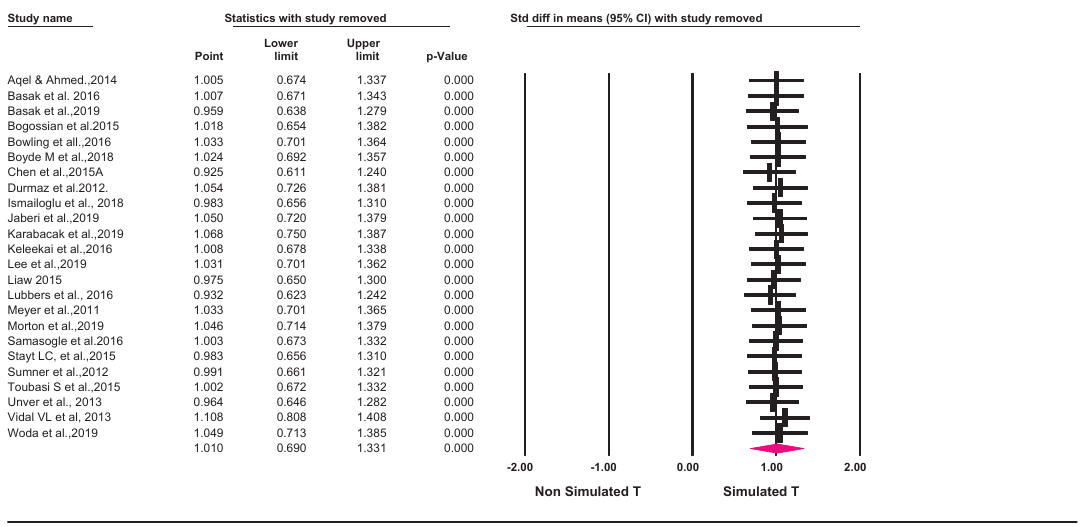
Figure 3. Forest plot showing sensitivity analysis by one study remove